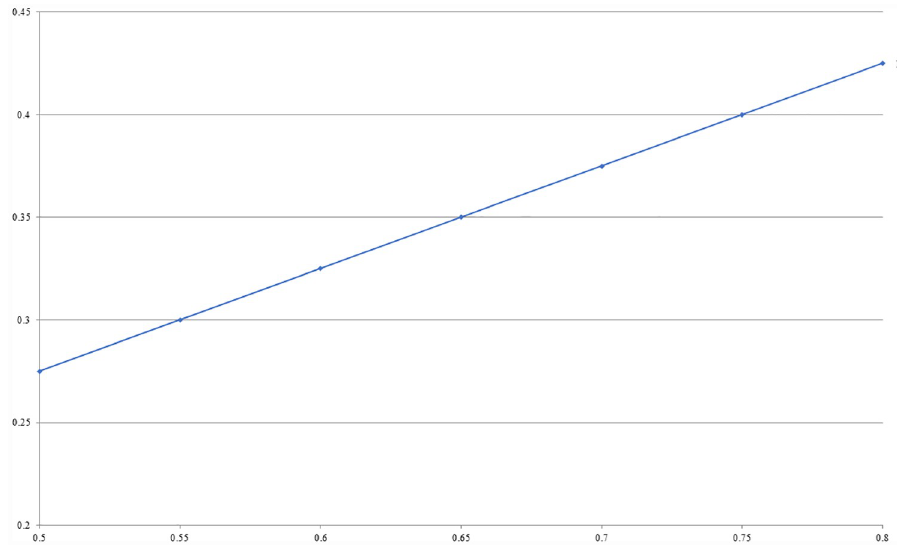
Fig 1. An illustration of the relation between price and b under